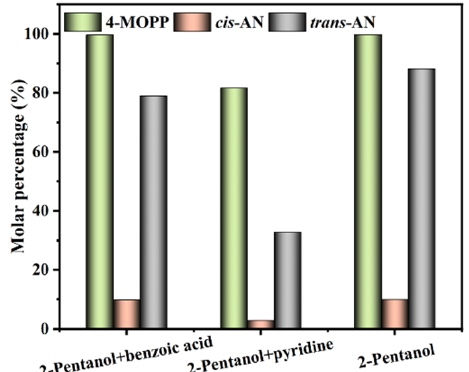
Figure 11. Results of the poisoning experiments; Reaction conditions: 1 mmol 4-MOPP, 10 mL solvent, 0.1 g PhP-Hf (1:1.5) catalyst, 220 °C for 2 h.